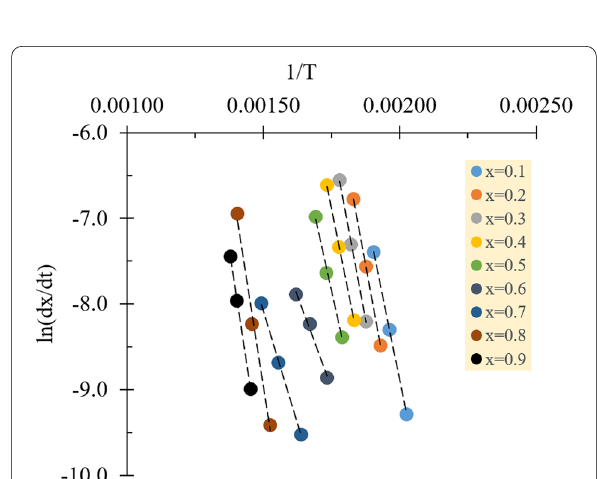
Fig. 5 Linear plots of ln(dx/dt) against 1/T for various conversion degree in Friedman method representing the entire combustion reaction